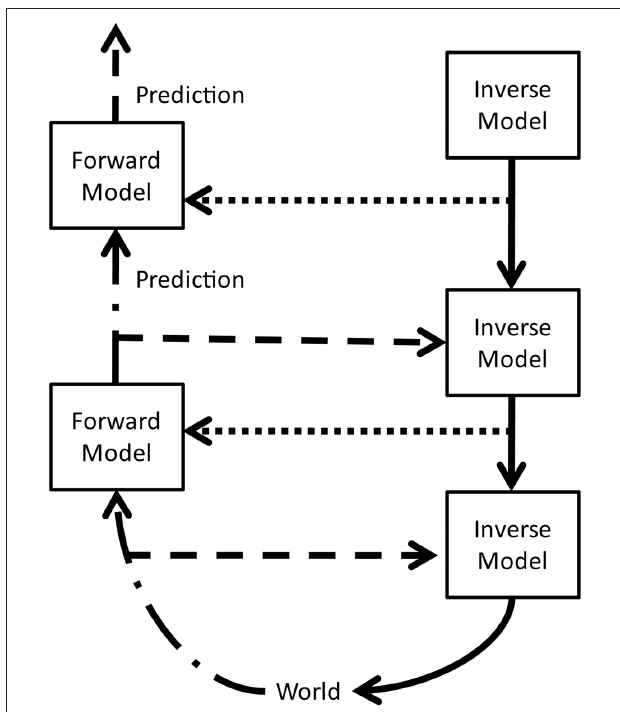
Figure 1 | A hypothetical model of hierarchical action–perception loops. Forward models receive the current state (dash-dot arrows) and an efference copy (dotted arrows) from lower loops and send their predicted state to higher loops; inverse models receive a copy of the current state (dashed arrows) and the goal state (solid arrows) from higher loops and send the motor command to lower loops. The same model can also be interpreted in a different manner: higher motor regions (inverse models) send motor commands (solid arrows) to lower motor regions and collateral efference copies (dotted arrows) to sensory regions (forward models). Lower sensory regions send predictions (dash-dot arrows) to higher areas and collateral motor commands (dashed arrows) to motor regions. Hence the ascending predictions (dash-dot arrows) can be viewed as efference copies of their collaterals (dashed arrows). The two views emphasize the inability to separate sensory/perception from motor/ action in such